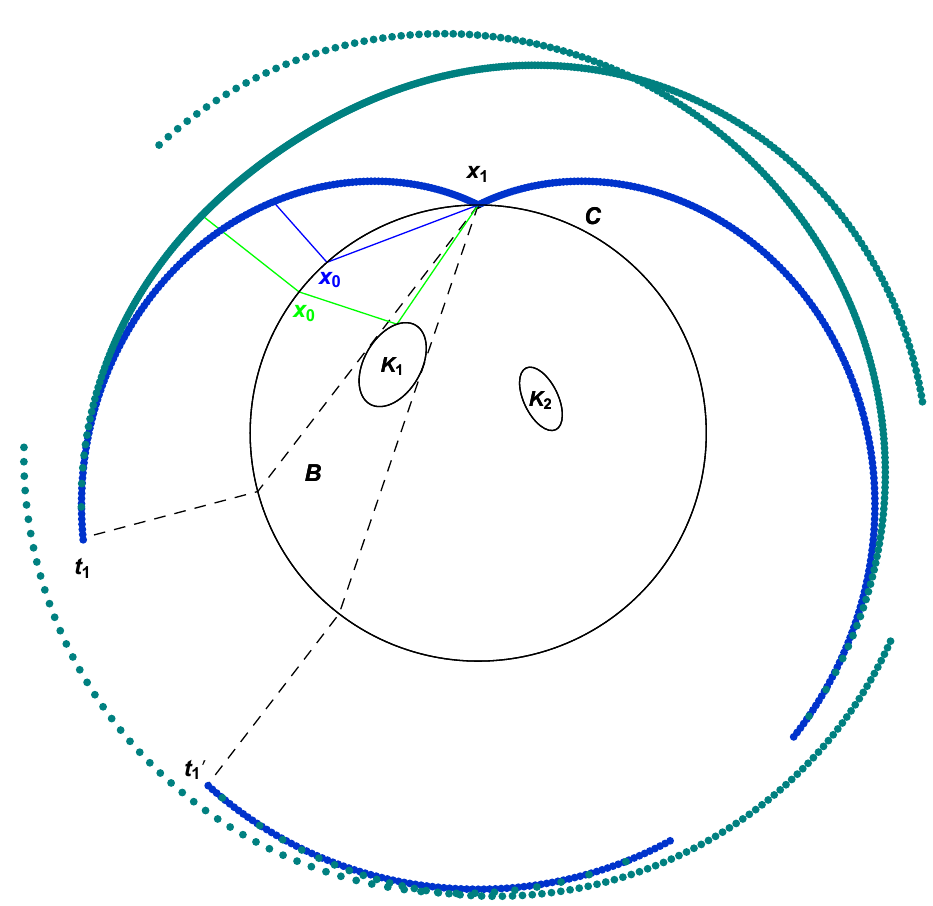
Figure 1. Part of the echograph (0 and 1 reflections), in Example